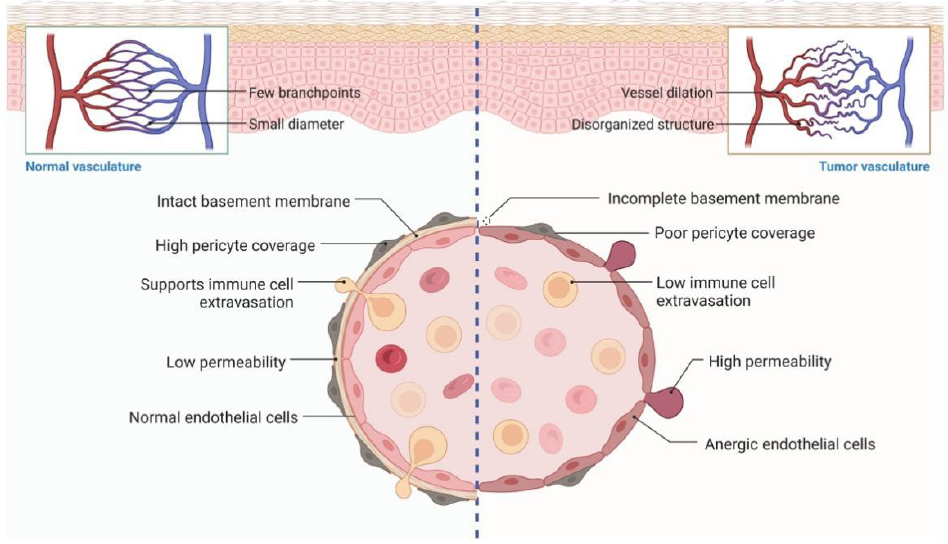
Figure 5. The vasculature usually transports nutrients, O 2 , growth factors, and waste products, which play an important role in tumor relapse, metastasis, and resistance. The vasculature was found to be complex, extended, branched, and have more loops in tumor tissue. The accumulation of metabolic waste and insufficient O 2 can promote acidic and hypoxic environments, which contribute to drug resistance.